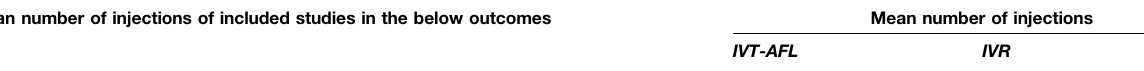
TABLE 7 | Mean number of injections at 1-year follow-up. Mean number of injections of included studies in the below